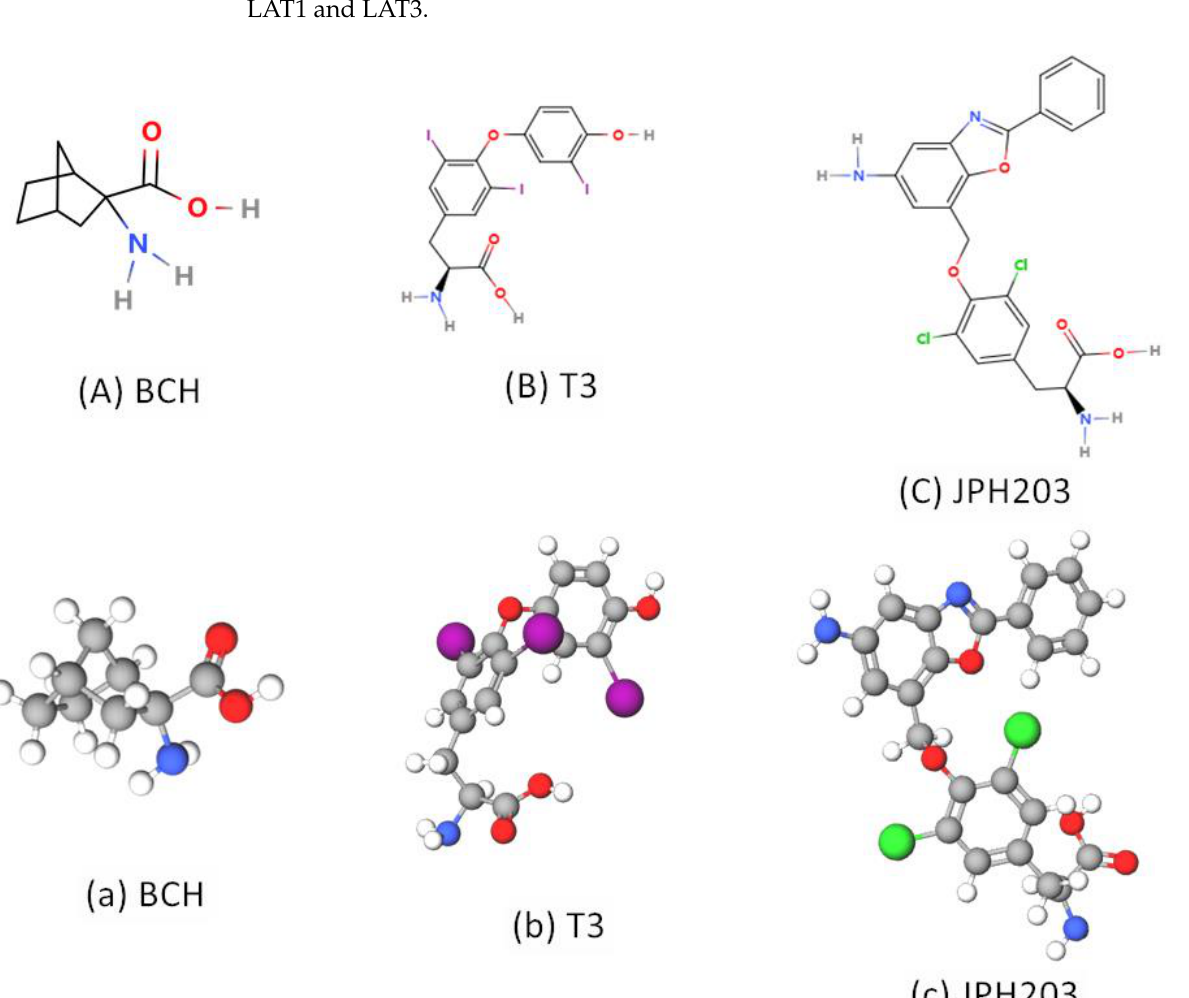
Figure 4. The 2D ( A – C ) and 3D ( a – c ) structures of LATs inhibitors. ( Aa ) BCH is a transportable system L inhibitor. ( Bb , Cc ) The core structures of T3 and JPH203 both contain an amino acid backbone and a bulky side chain.